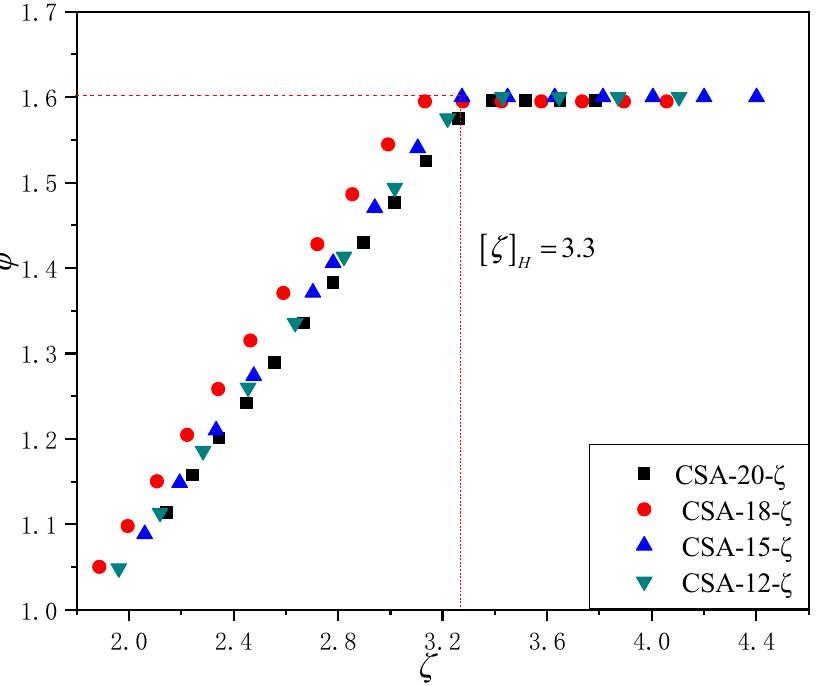
ϕ Figure 13. -of the CSA-BRBs in Table 1 under cyclic axial loads. Figure 13. ϕ -of the CSA-BRBs in Table 1 under cyclic axial